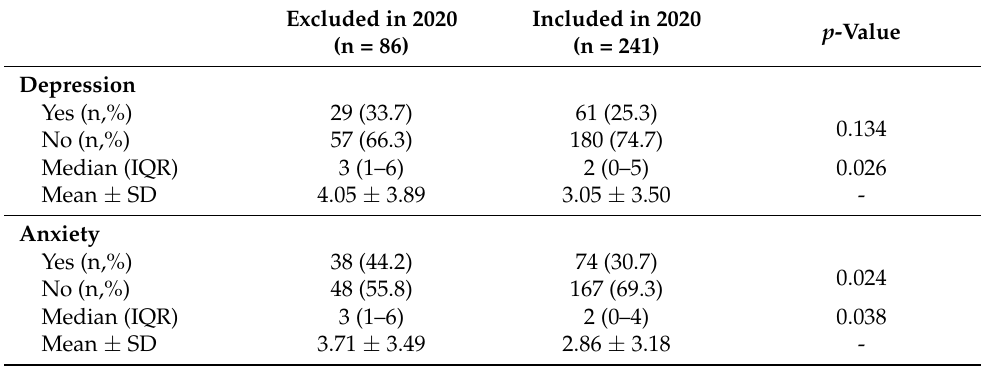
Table A3. Comparison of the 86 HCWs who were excluded from the 2020 cohort (19 ED staff resigned, 22 temporarily deployed staff to ED and 45 responses unable to be matched to 2nd survey) with the 241 HCWs who were